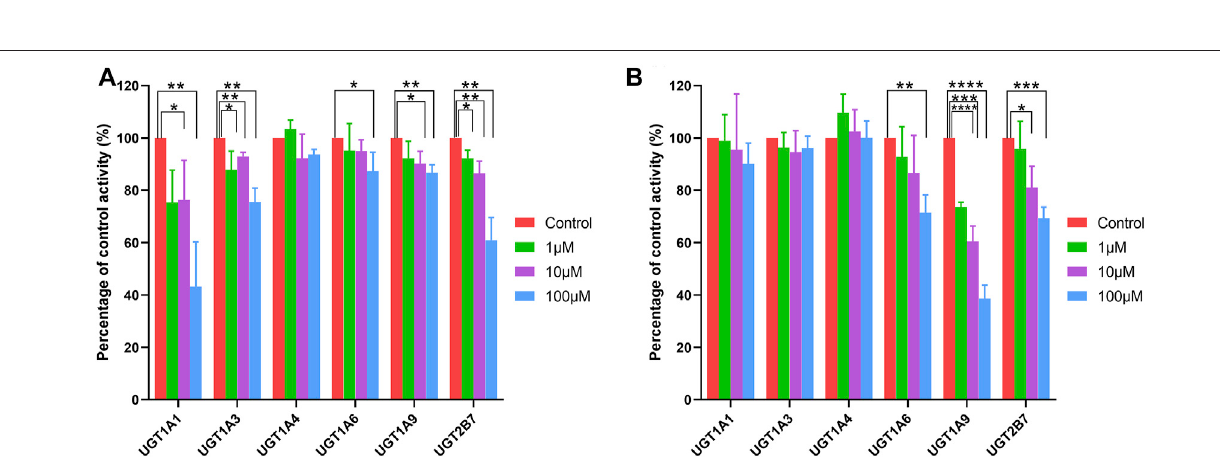
Frontiers in Pharmacology |